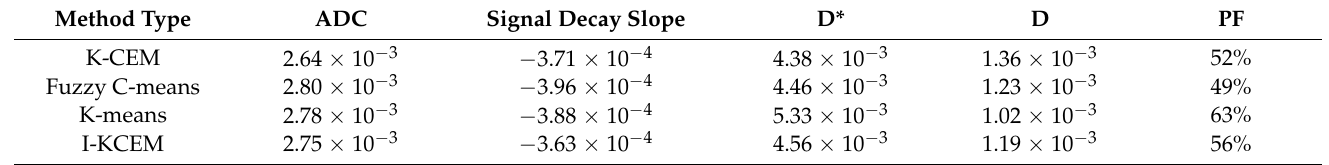
Figure 16. Signal-intensity decay of a cyst detected by the four methods using different b values in the 8th slice. Table 4 shows ADC, signal decay slope, D*, D, and PF parameter values for a cyst obtained by using different detection methods: K-CEM, fuzzy C-means, K-means, and I-KCEM. Table 4. Results of applying different detection methods to a cyst tumor.